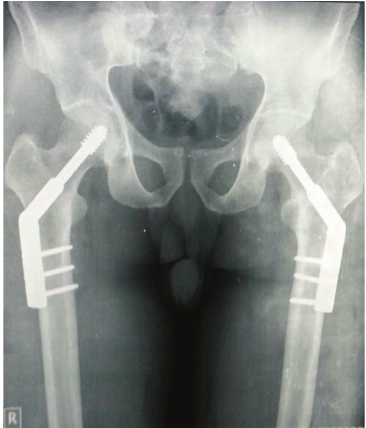
Figure 6: 6 months postoperative X-ray of bilateral hip joint with pelvis showing 3 holed dynamic hip screw implant in situ with no articular